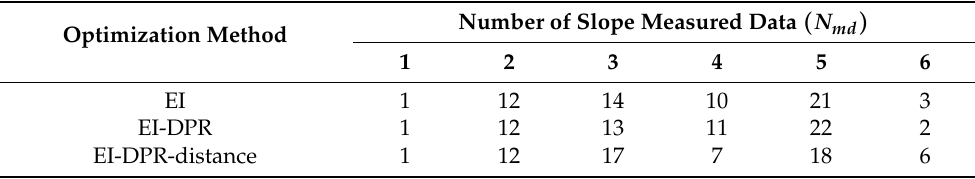
Table 4. Sensor location in the FEM model used for estimation (Case 1: slope only).